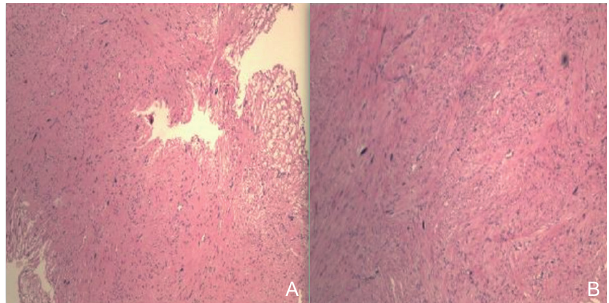
A Figure 4 Histopathological studies show that there is a proliferation of spindle-shaped cells, with no evidence of malignant change (A). Bladder leiomyomas also stain negatively for Ki-67 (<5%+), but they are positive for smooth muscle staining, as actin and desmin(B).